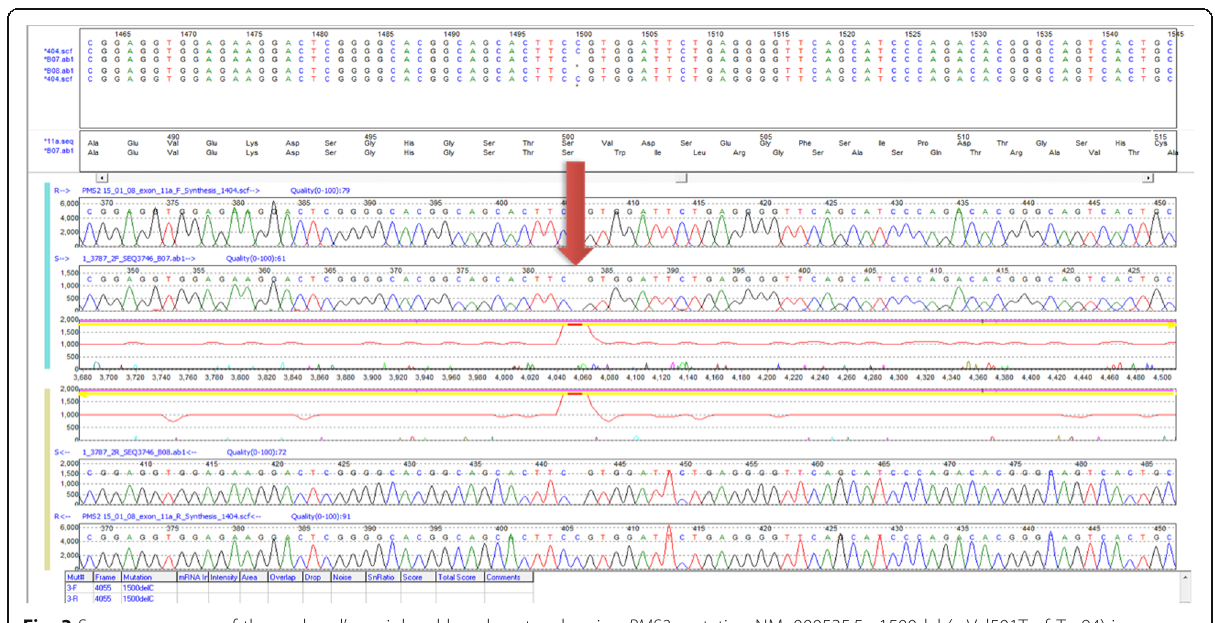
Fig. 3 Sanger sequence of the proband ’ s peripheral lymphocytes showing PMS2 mutation NM_000535.5:c.1500del (p.Val501TrpfsTer94) in exon 11. Arrow points to homozygous loss of cytosine at the 1500